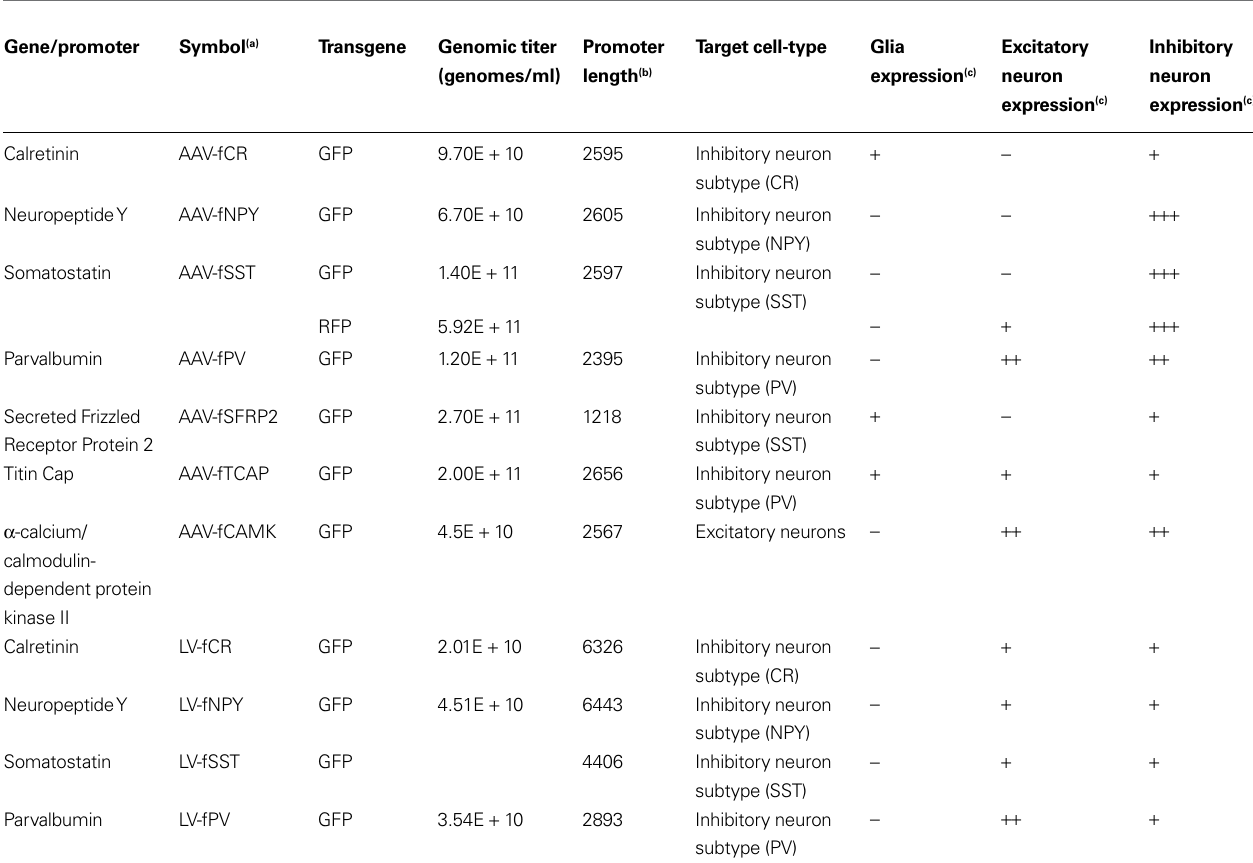
Table 1 | AAV and LV vectors with fugu